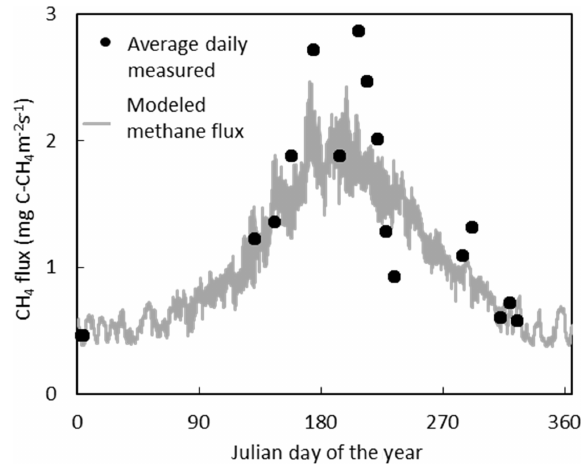
Figure 5. The average daily CH 4 flux measured in the field com- pared to the modeled temporal fluctuations in CH 4 flux for 2017.